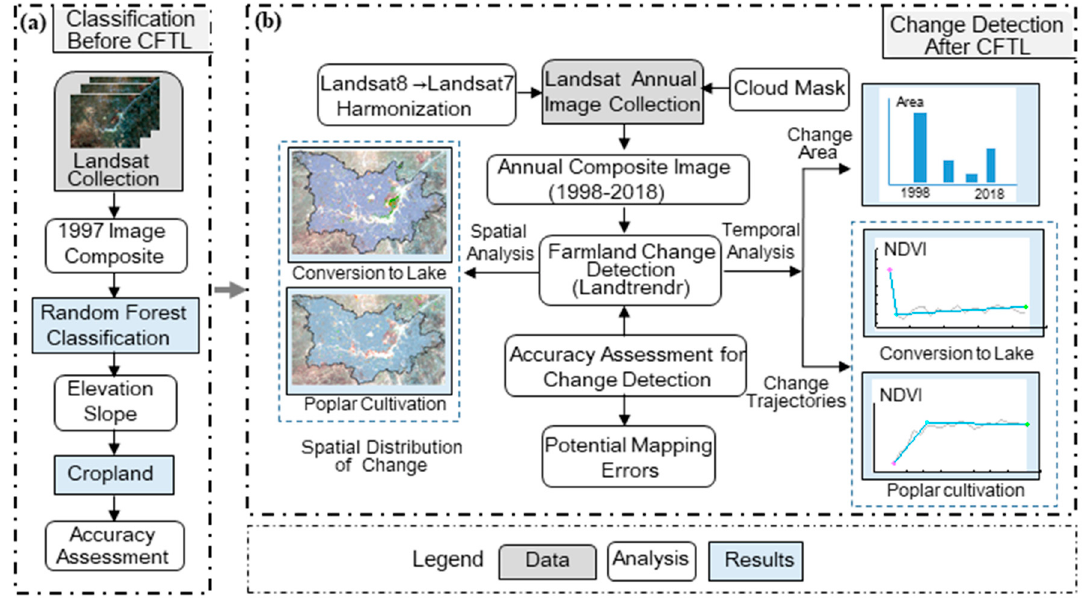
Figure 4. Methodological flowchart for ( a ) pre-CFTL land-use classification and ( b ) post-CFTL analysis of conversion to lake and poplar cultivation.